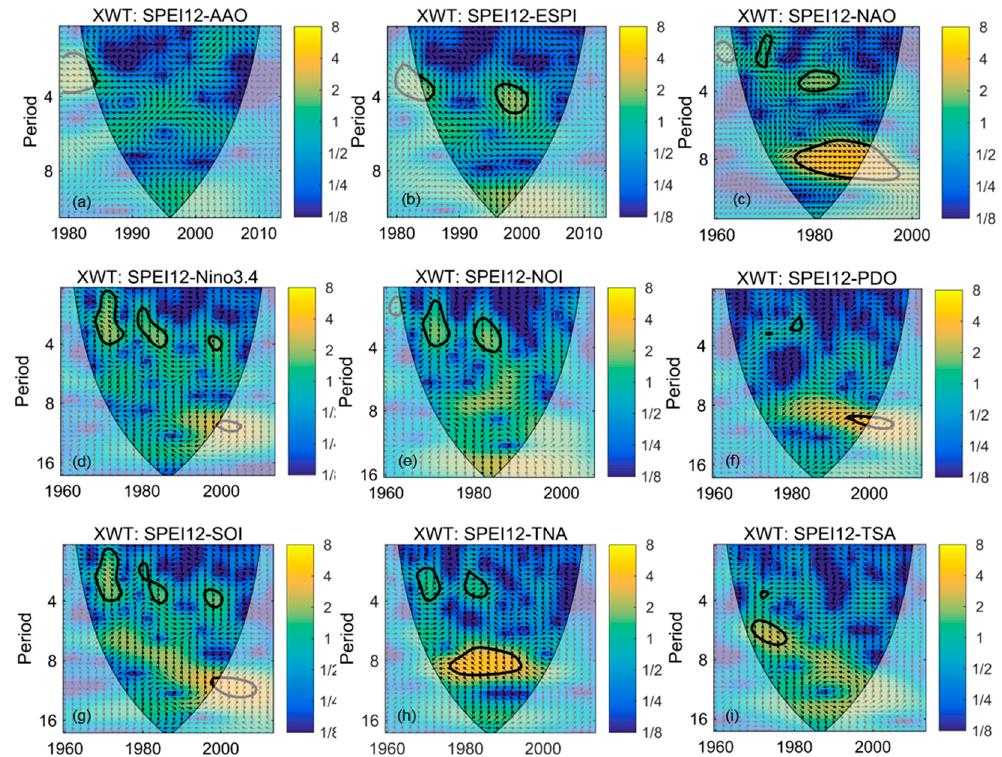
Figure 4. The results of Cross Wavelet Analysis (XWT) of SPEI (at 12-month scale) and the GCV.